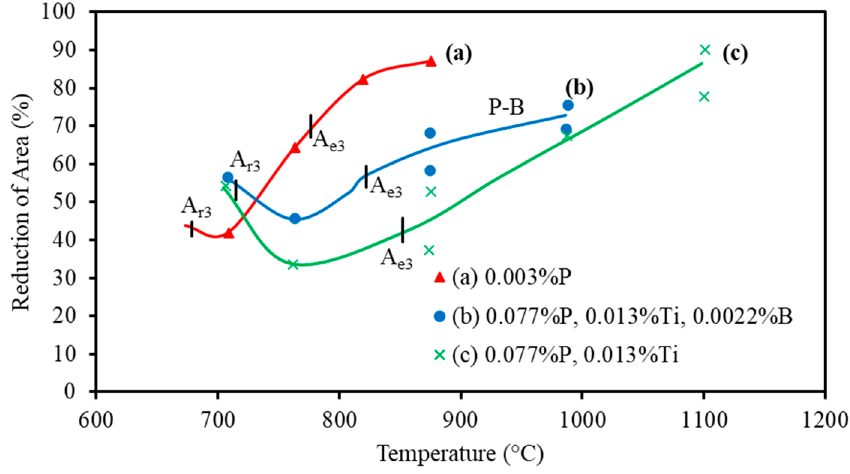
Figure 8. Hot ductility curves for C-Mn TRIP-assisted steels (0.15–0.2% C, 1–1.45% Mn, 0.3% Si): (curve a) 0.003% P; (curve b) 0.077% P, 0.013% Ti and 0.0022% B; (curve c) 0.077% P and 0.013% Ti [36]. Adapted from [36], with permission from Taylor & Francis Group, 2022.